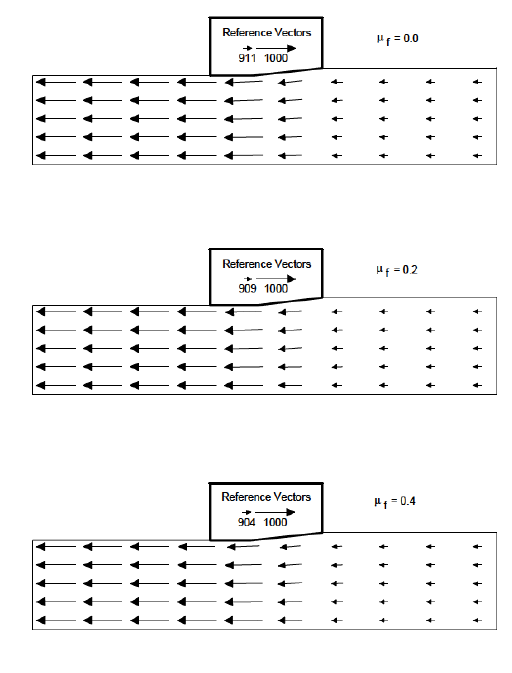
Fig. 5. Velocity vectors at friction coefficients µ f = 0.0 , µ f = 0.2 and µ f = 0.4 .